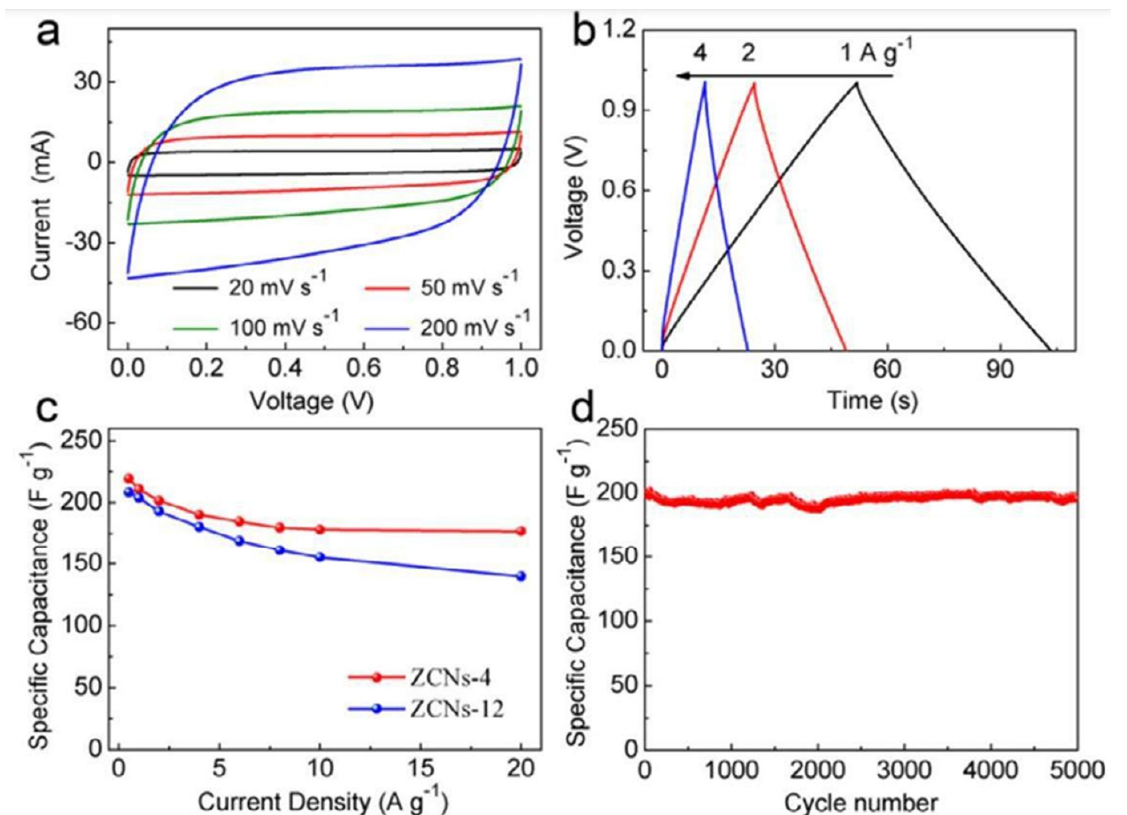
Figure 7. Electrochemical performance of ZCNs electrodes: ( a ) CV curves of ZCNs-4 at various scanning rates; ( b ) galvanostatic charge/discharge curves under various current densities for ZCNs-4; ( c ) specific capacitance dependence on current density of ZCNs-4 and ZCNs-12; ( d ) long-term cycle stability of ZCNs-4 at a current density of 2 A g − 1 . Reproduced with permission from [69].